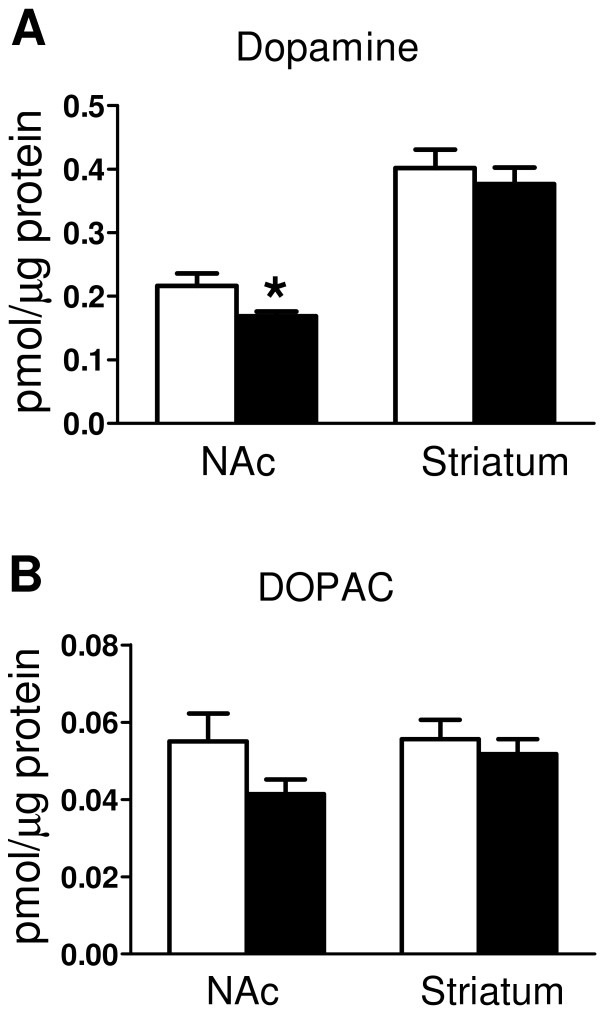
Dopamine is reduced in tissue punches of the NAc but not dorsolateral striatum of mGlu2/3-/- mice. A: Dopamine content is reduced in tissue punches of NAc but not dorsolateral striatum of mGlu2/3-/- mice (black) compared to wildtypes (white). NAc n = 12 WT, 12 KO and dorsolateral striatum n=12 WT, 14 KO. B: DOPAC shows a trend towards reduction in the NAc of mGlu2/3-/- mice (p=0.1). NAc n = 12 WT, 14 KO and dorsolateral striatum n= 12 WT, 15 KO. Monoamine concentration is normalised to the total protein content of the punches. Graphs show mean ±SEM; all one-way ANOVA except striatal DOPAC, analysed with Mann Whitney U test, *p=0.037.